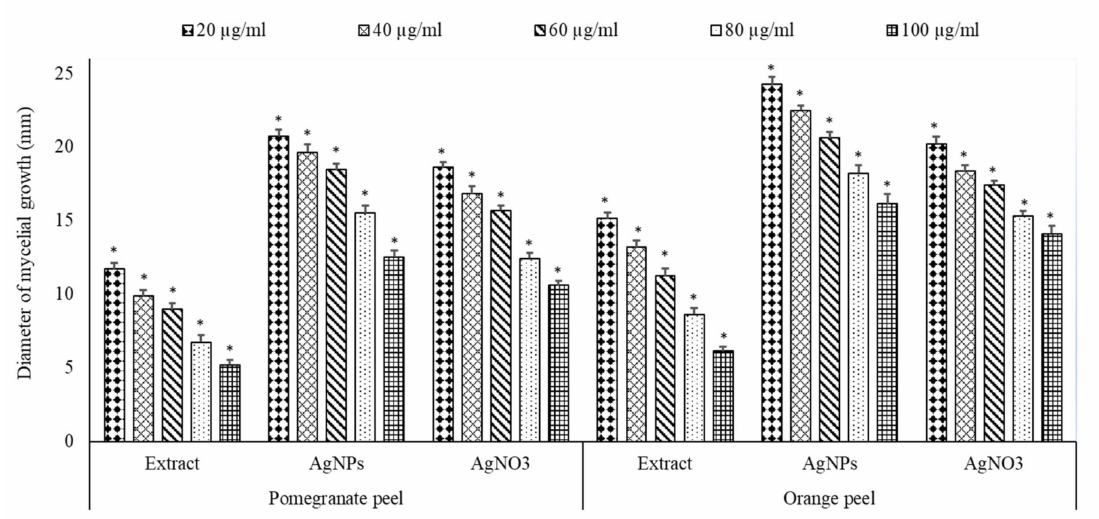
Figure 11. Antifungal activity of crude extract of pomegranate and orange peels, AgNPs and AgNO 3 against A. solani (Highly significant = * p < 0.01, n =